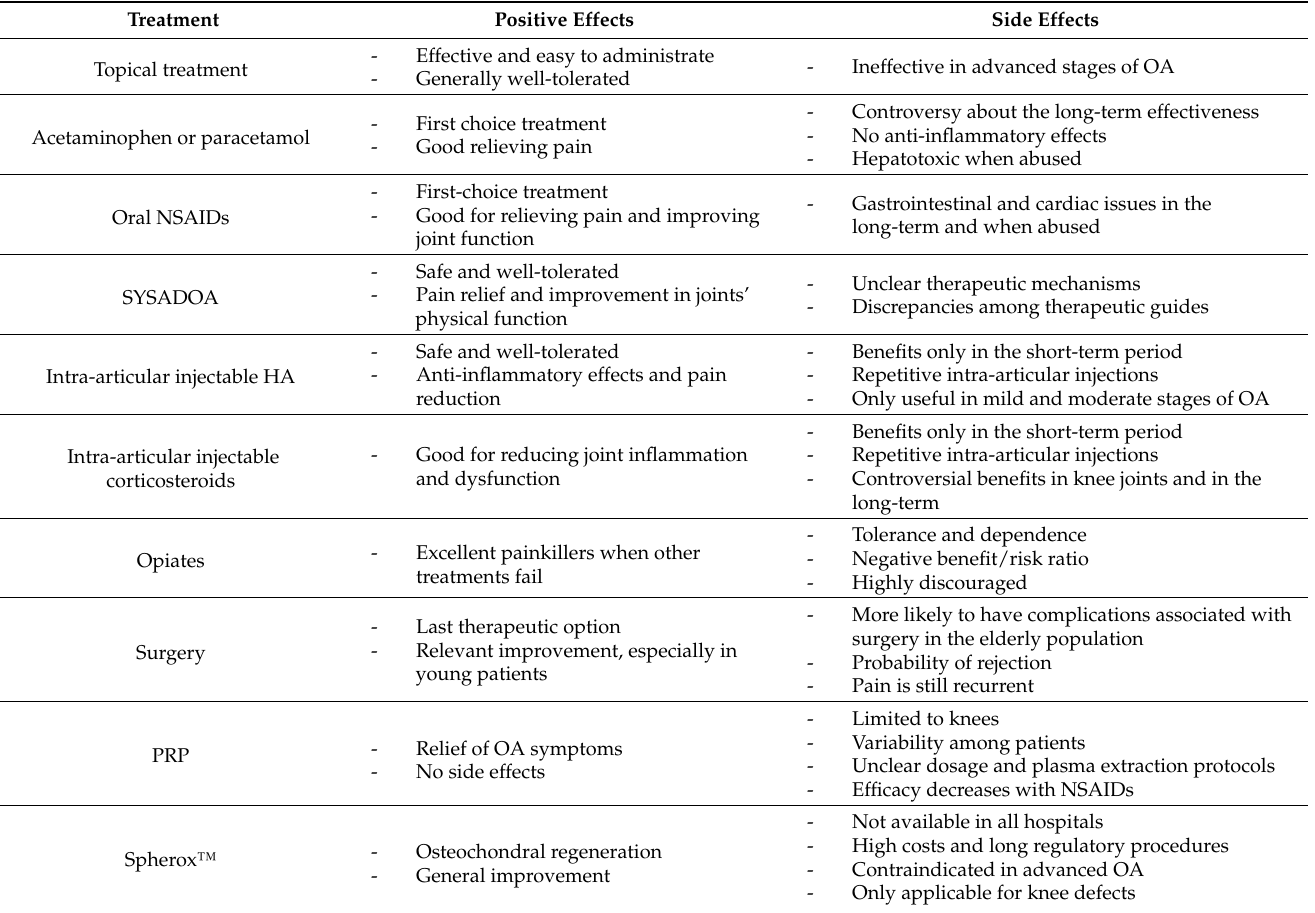
Table 1. Summary of the benefits and side effects of the current treatments for